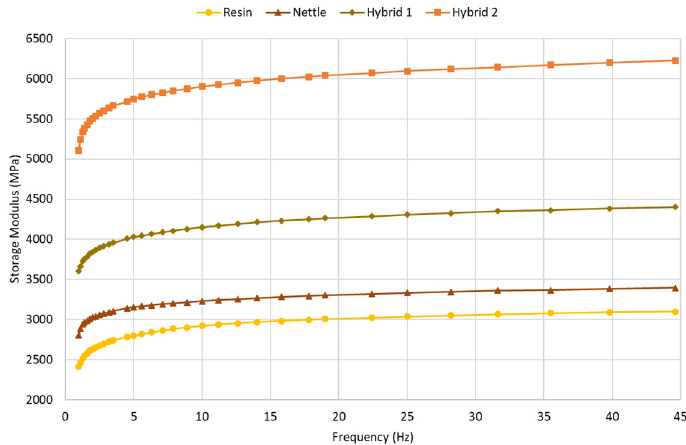
Figure 6. Variation of storage modulus with frequency.